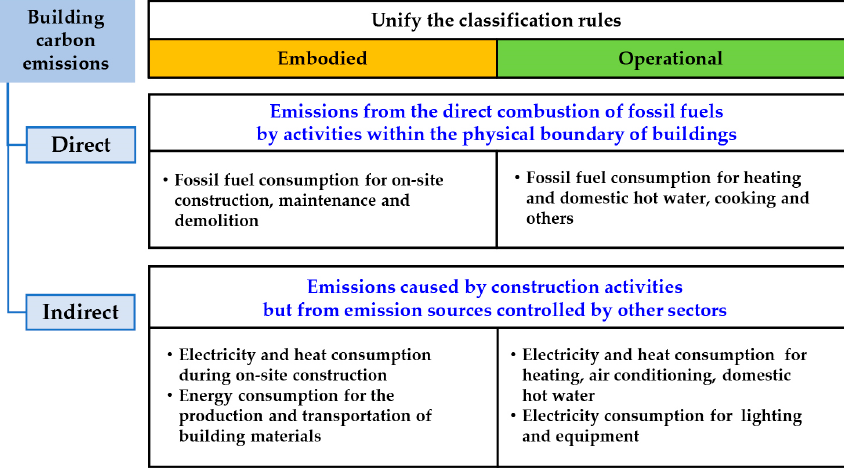
Figure 3. Classification of building direct and indirect emissions.